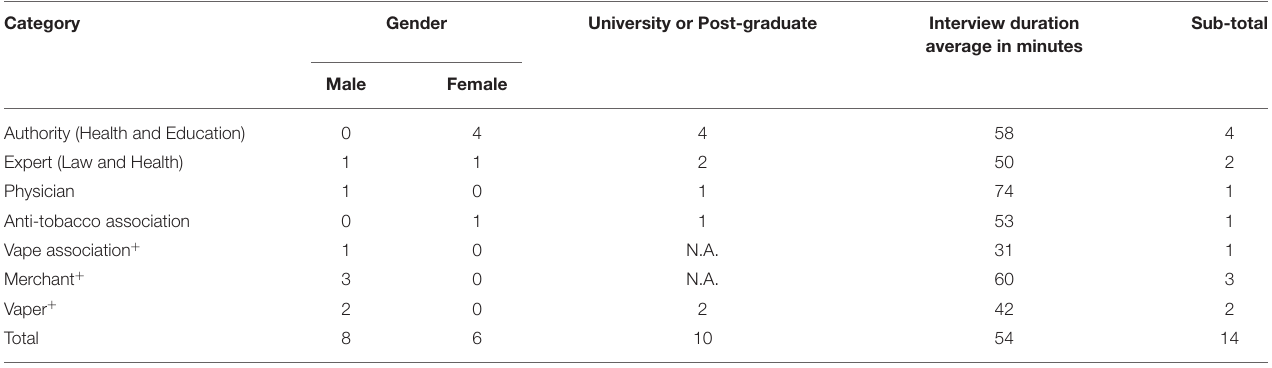
TABLE 1 | Characteristics of stakeholders interviewed in Taiwan. Category